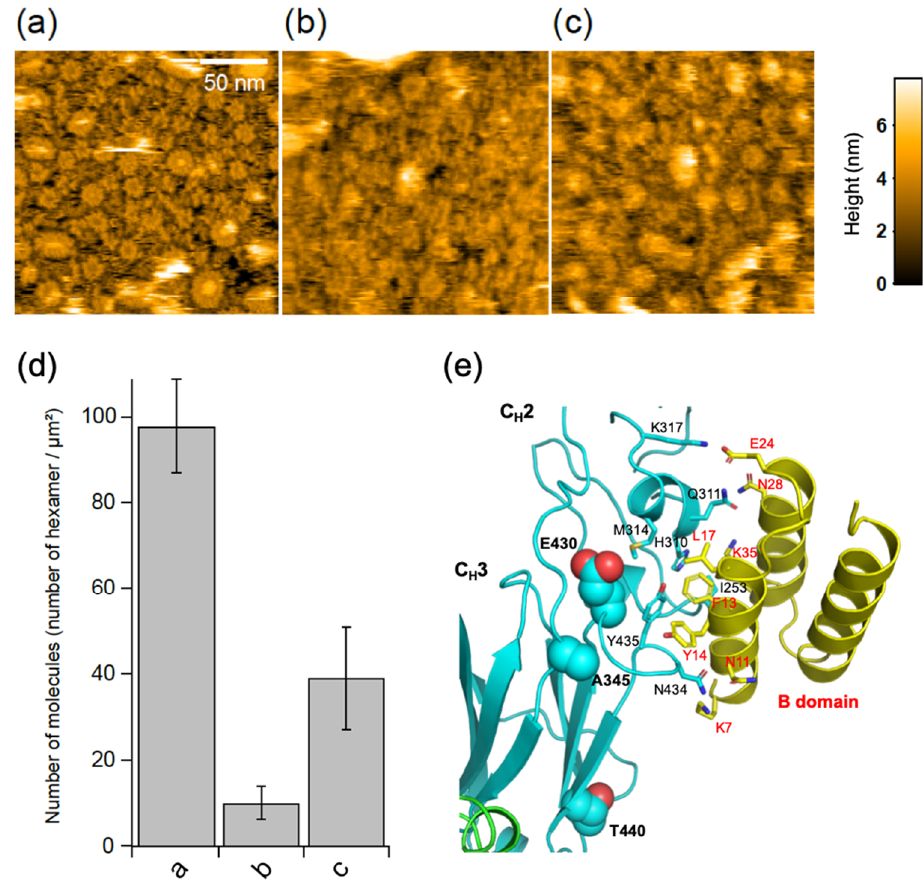
Figure 4. E ff ects of the B domain of protein A and hinge disulfide cleavage on IgG ring formation. HS-AFM images of GB2 in the ( a ) absence or ( b ) presence of the B domain of protein A or ( c ) reduced and alkylated GB2 on the 50% GM1-incorporated DOPC membranes. ( d ) Summary of the number of IgG hexamers in each treatment. Each bar corresponds to the data obtained under the conditions of a, b, or c. ( e ) X-ray crystallographic structure of Fc interacting with B domain of protein A. Residues involved in the interaction are shown as sticks, whereas the corresponding residues in the human Fc that were mutated to enhance hexamer formation are shown as balls.